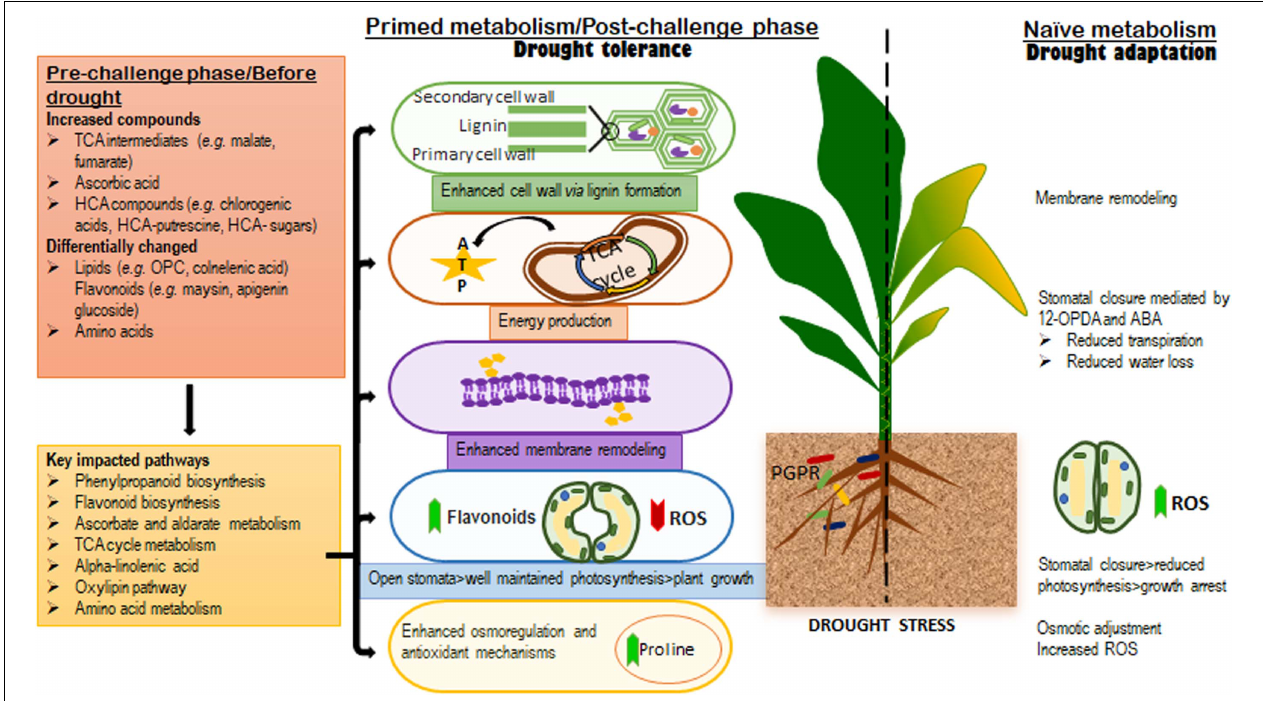
FIGURE 7 | A contextual summary of the results obtained in this study. The left side of the dotted line highlights the metabolic and biochemical events in microbial-based biostimulants treated plants; the changes observed in the pre-challenge phase (well-watered conditions), were found to be related to growth promotion and defense preconditioning, whereas, the alterations in the levels of metabolites spanning the key significantly impacted pathways identified in the post-challenge phase (after drought application) were associated with biostimulant-enhanced drought tolerance mechanisms and a “primed” metabolism. The right side of the dotted line shows the naïve metabolic responses to drought stress, which are associated with evolutionally developed drought adaptation mechanisms.